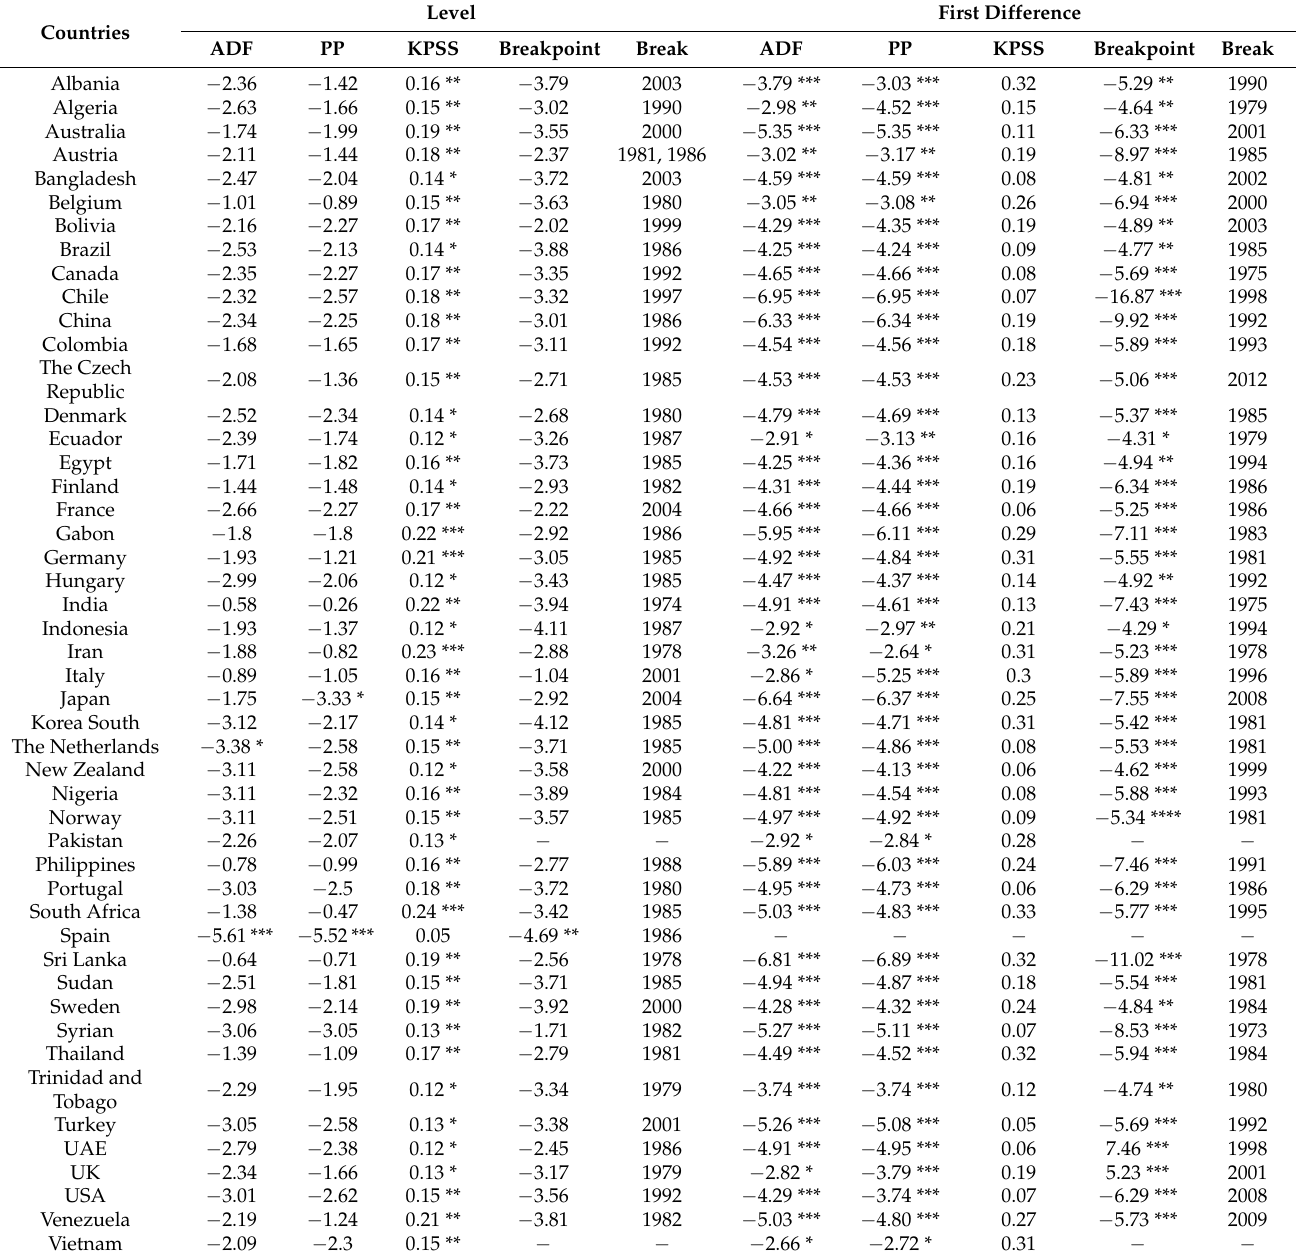
Table A1. Unit root test—real GDP per capita